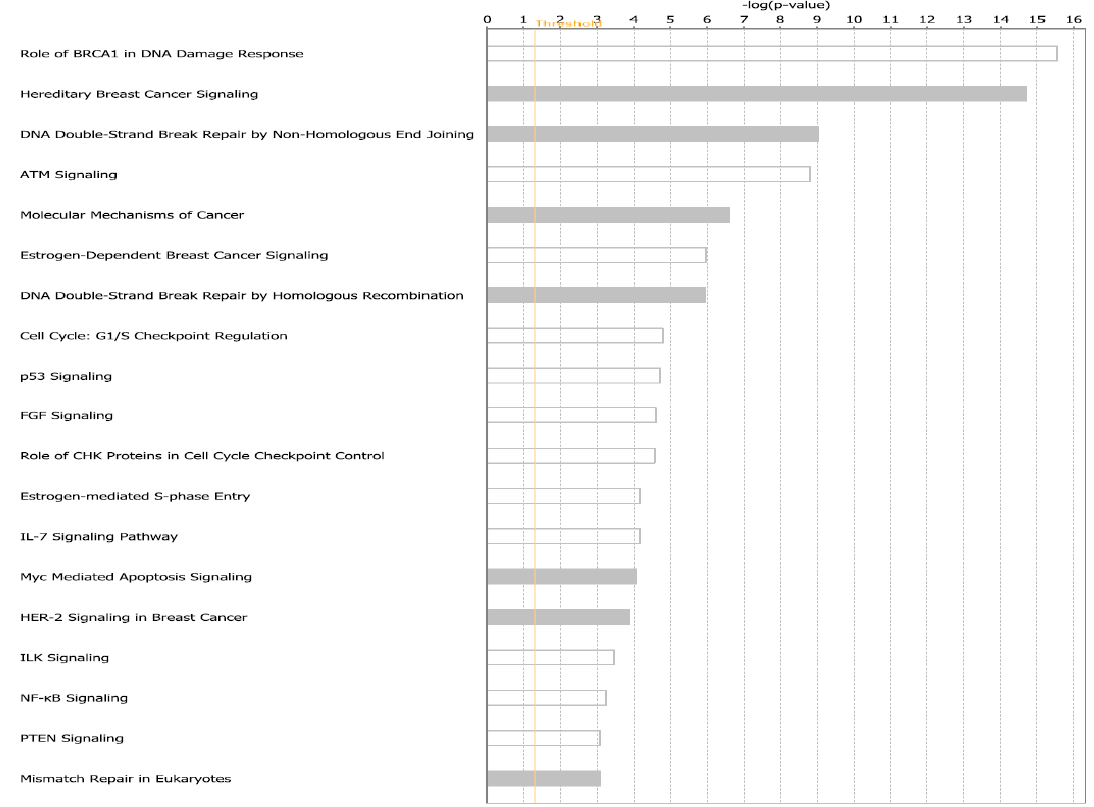
Figure 6. Top most significant pathways enriched for germline, somatic, and epigenomic variations for genes associated with TNBC.